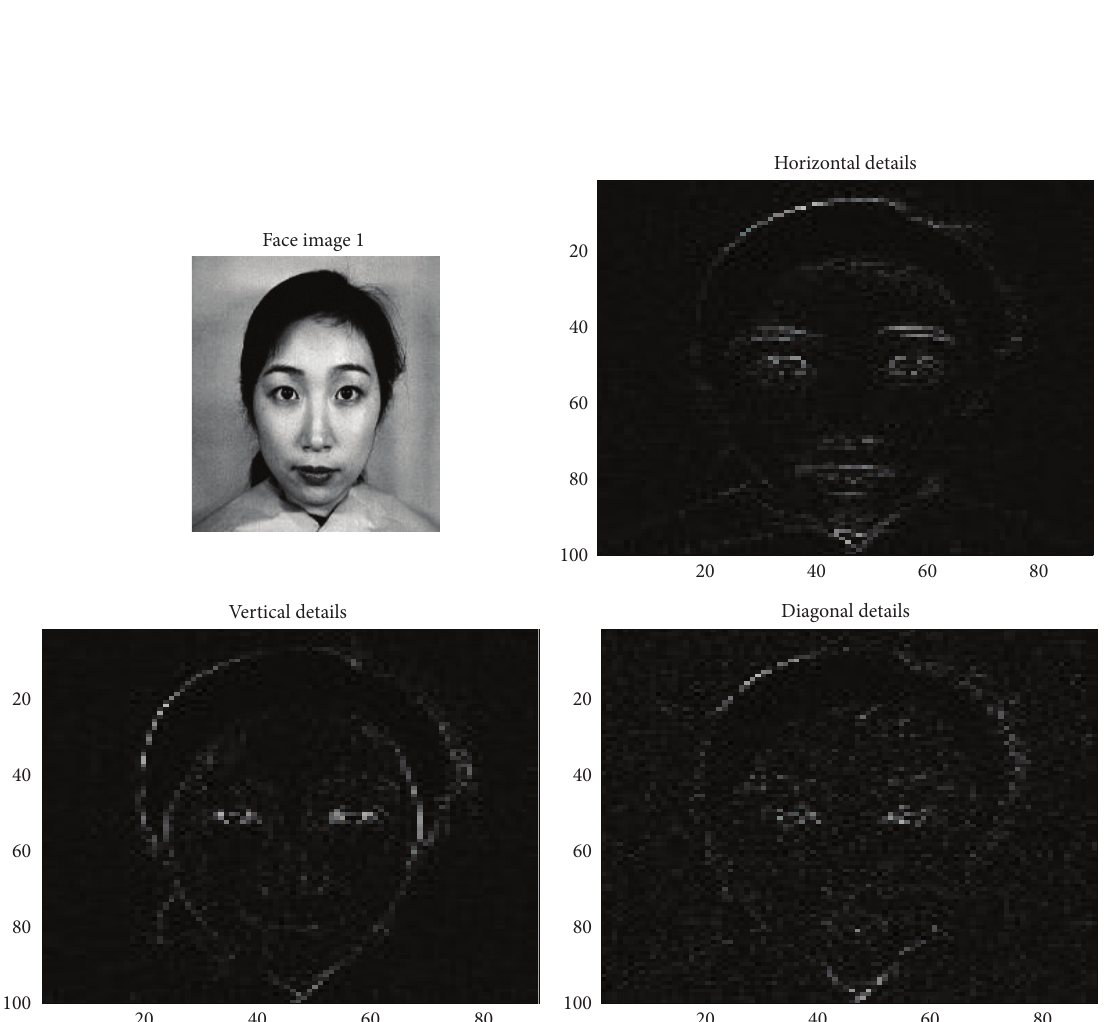
Figure 2: 2 × 2 descriptor array computed from an 8 × 8 set of samples [18].